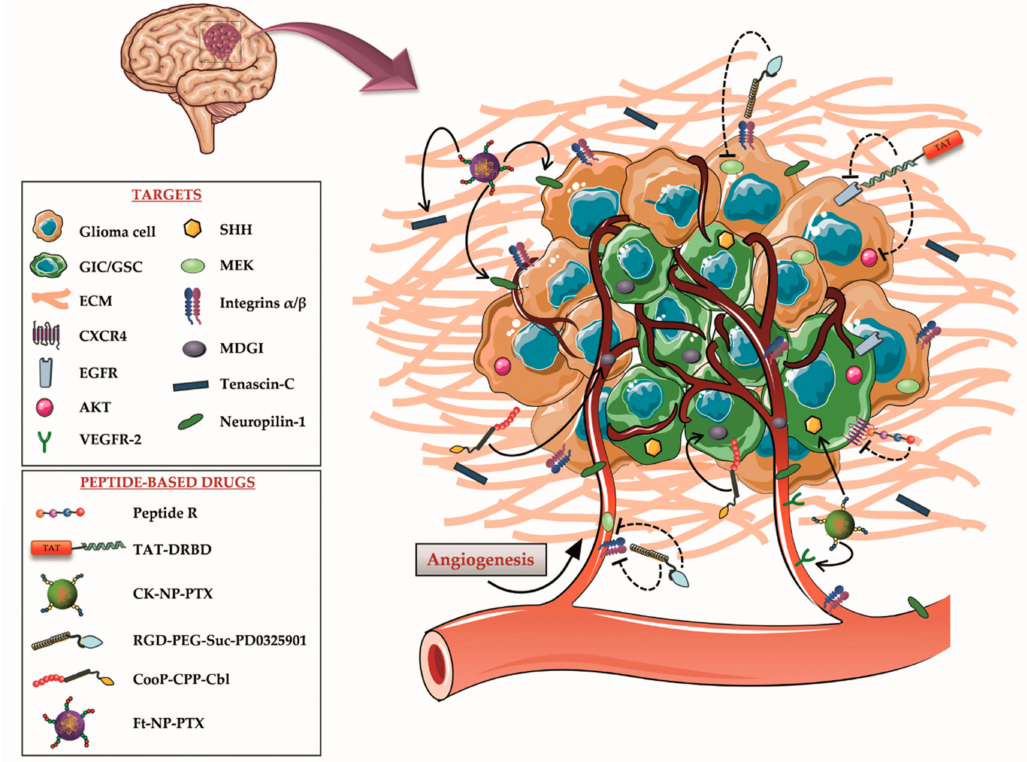
Figure 1. Schematic drawing of high-grade astrocytoma structure, microenvironment, and molecular targets. In the last few years, many key signaling pathways for astrocytoma development and invasivenesshavebeenidentifiedondi ff erentcomponentsofthetumormass, includingglioma-initiating cells (GICs), glioma cells, extracellular matrix (ECM) and vasculature. Several peptide therapeutics and peptide-based drugs, addressing these targets, have been subsequently designed to maximize